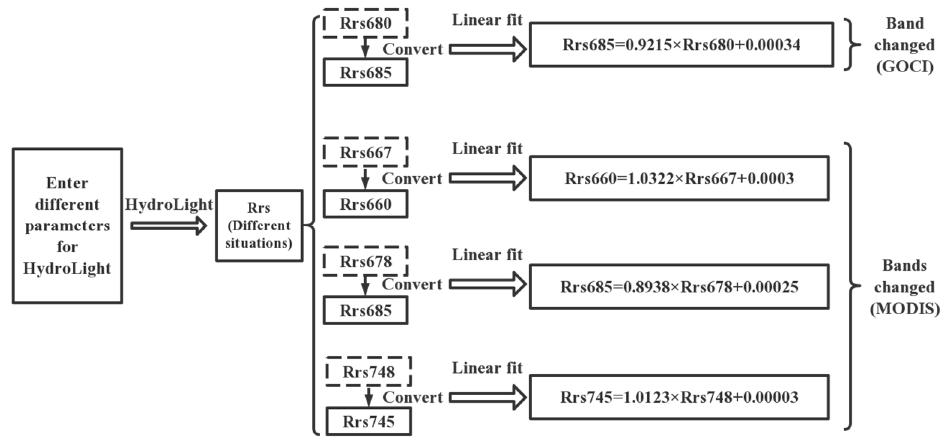
Figure 6. Band conversion flowchart.